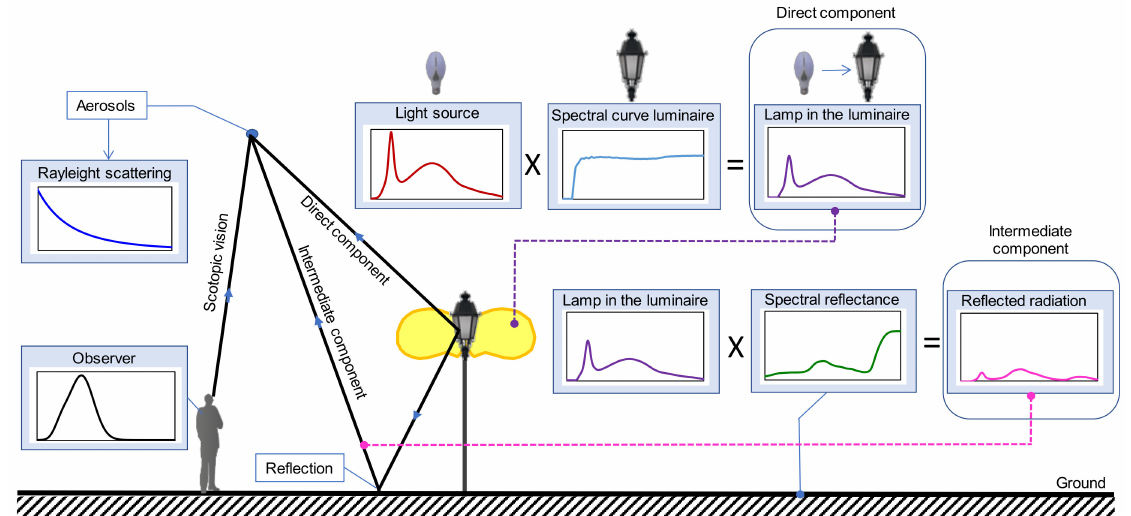
Figure 12. Illustrative presentation of the factors affecting the